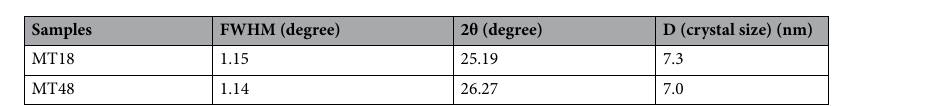
Table 1. The crystal size calculation from XRD structure according to Debye Scherrer equation.